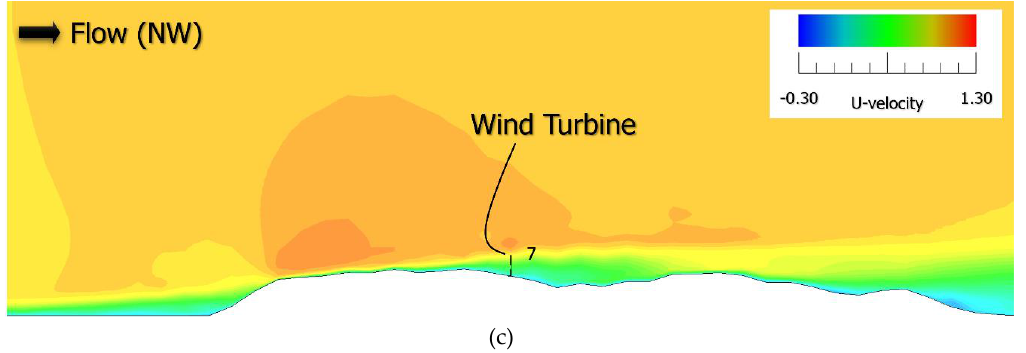
Figure 32. Comparison of the spatial distribution of time-averaged U-velocity passing through WT #7 for north-westerly wind—(a) 5 m, (b) 25 m, and (c) 50 m.